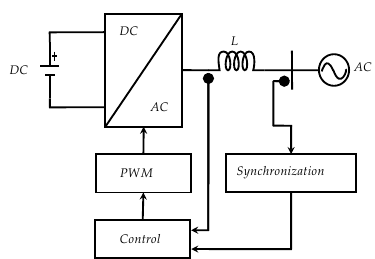
Figure 1. Simple representation of grid-connected inverter.